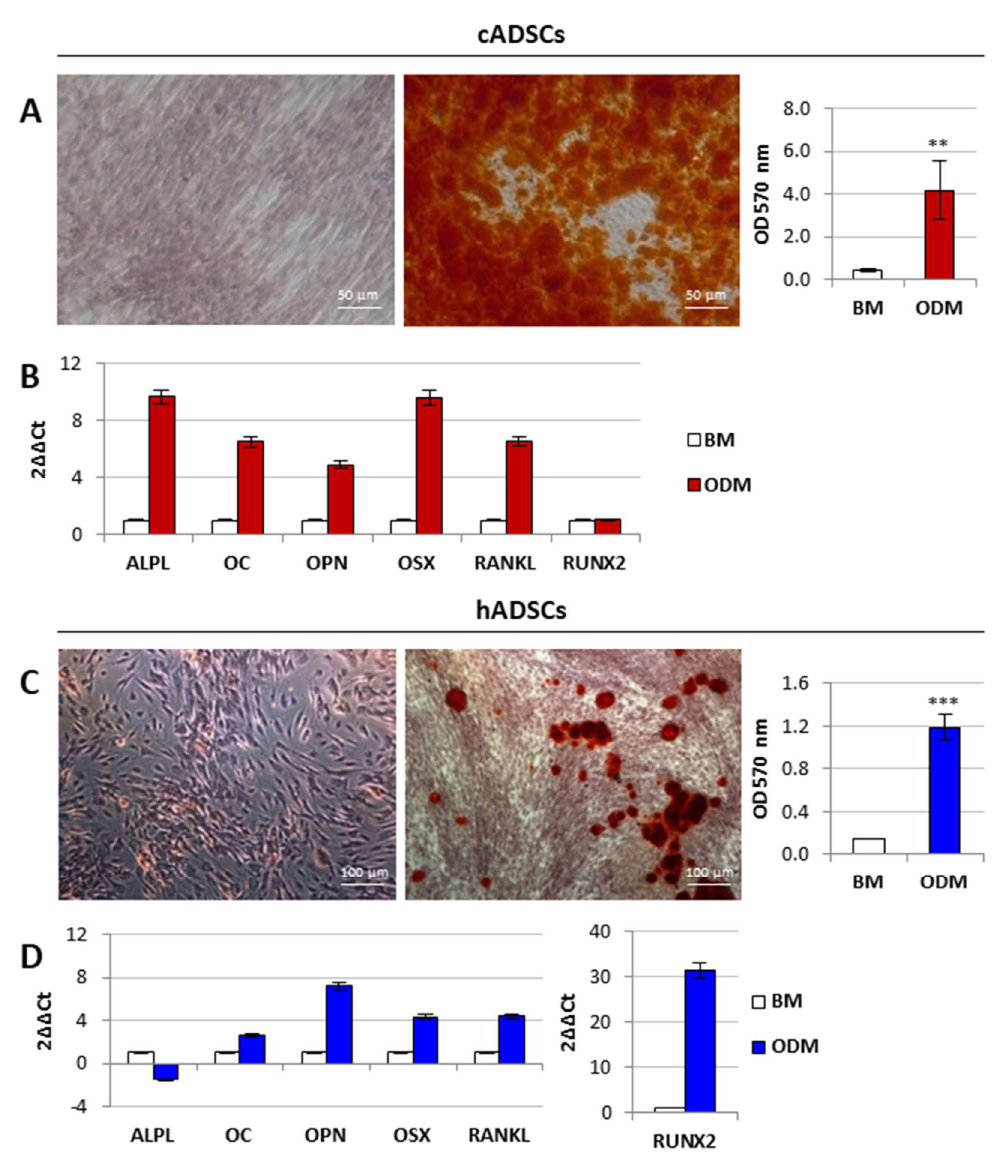
Figure 5. In vitro osteogenic differentiation potential of cADSCs and hADSCs. ( A , C ) Alizarin Red S (ARS) staining and quantification of calcium deposits in cADSCs (magnification 20 × ) and hADSCs (magnification 10 × ), respectively, after 21 days of osteogenic differentiation in osteogenic differentiation medium (ODM). Data are expressed as mean ± SD ( n = 3). ** p < 0.01, *** p < 0.001 indicate statistically significant difference compared to cells grown in Basal Medium (BM). ( B , D ) Gene expression profiles of the osteogenic markers ALPL, OC, OPN, OSX, RANKL, and RUNX2 in cADSCs and hADSCs,